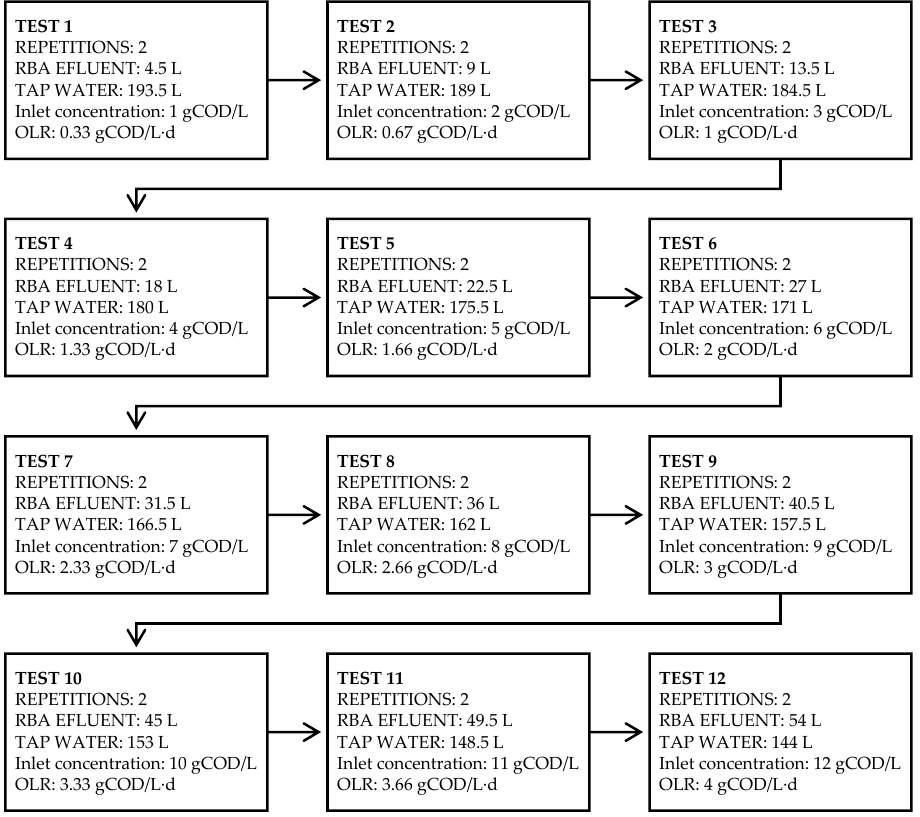
Figure 3. Hydraulic regimes and organic loading rates for the CW.